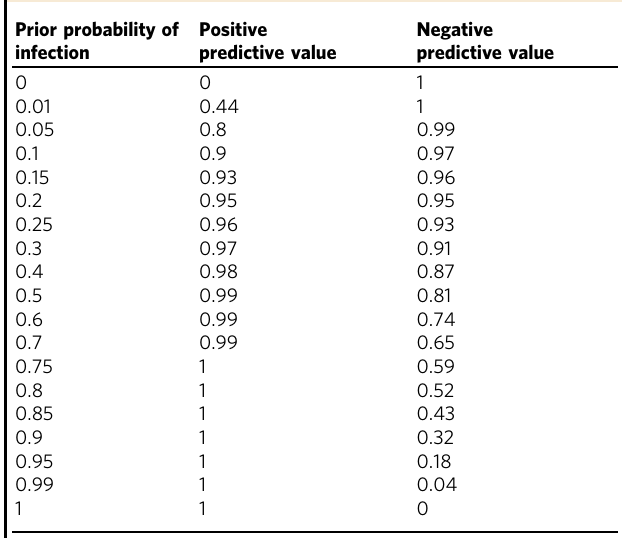
Table 5 EBOV mock clinical trial prior